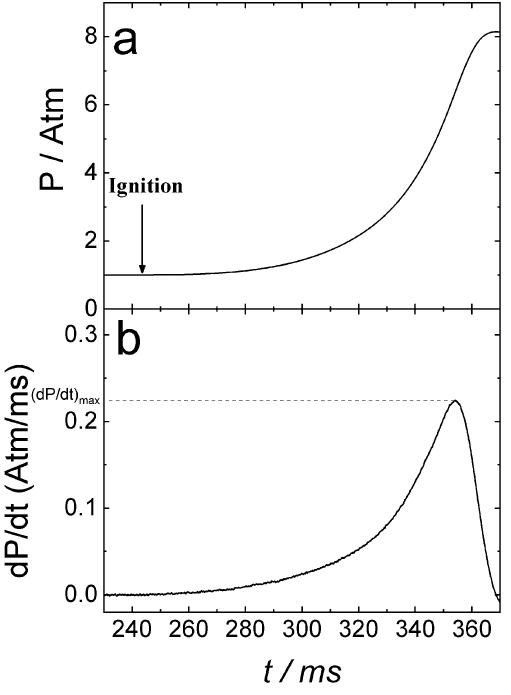
Fig. 13 Pressure ( a ) and time derivative ( b ) versus time for the combustion of aerosol/methane mixture in air. The aerosol and methane concentrations are 40 and 20 g/m 3 ,